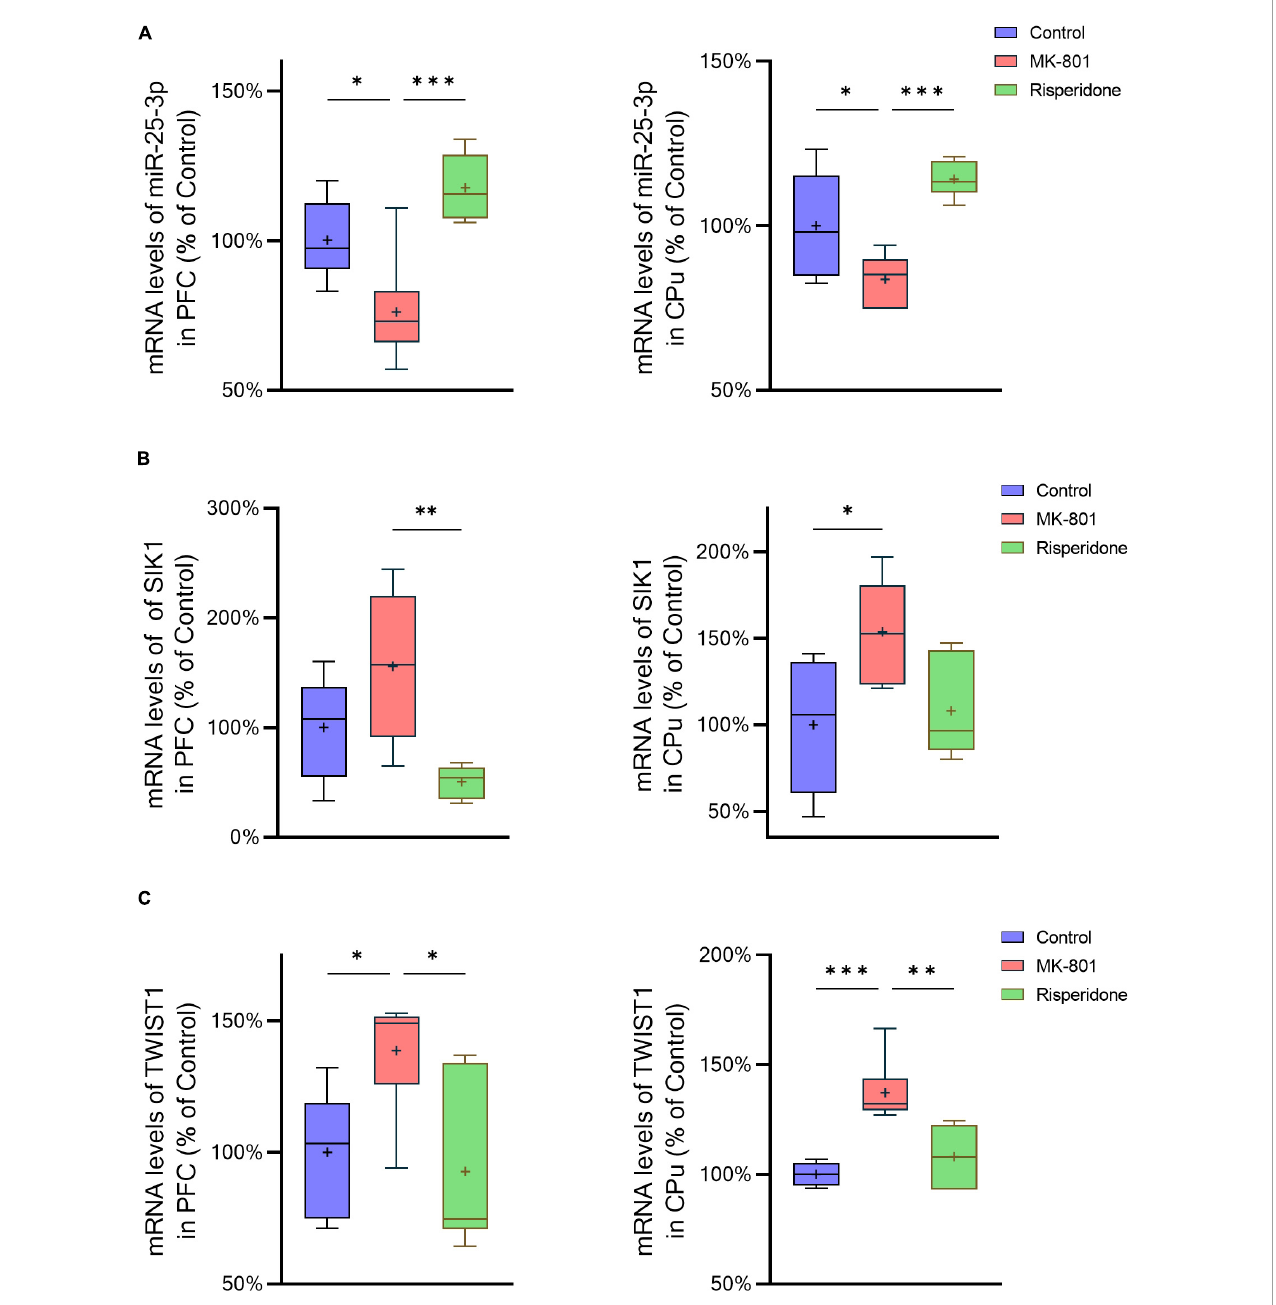
FIGURE2 Altered mRNA expression of miR-25-3p, SIK1, and TWIST1 induced by the repeated MK-801 administration in the prefrontal cortex and caudate putamen. (A) The mRNA expression of miR-25-3p was decreased in the model rat prefrontal cortex (PFC) and caudate putamen (CPu), which was restored by risperidone. (B) The SIK1 mRNA expression were up-regulated in the model rat PFC and CPu; risperidone also reversed these alterations. (C) The TWIST1 mRNA expression was inhibited in the model rat PFC and CPu, which can be reversed to near normal levels by risperidone. ∗ P < 0.05, ∗∗ P < 0.01, ∗∗∗ P < 0.001, + mean